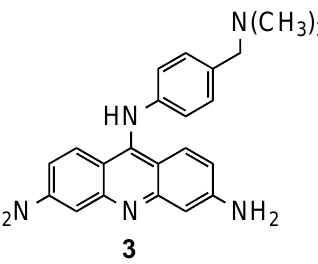
Figure 3. Compound 3 developed by Auparakkitanon and co-workers [13].